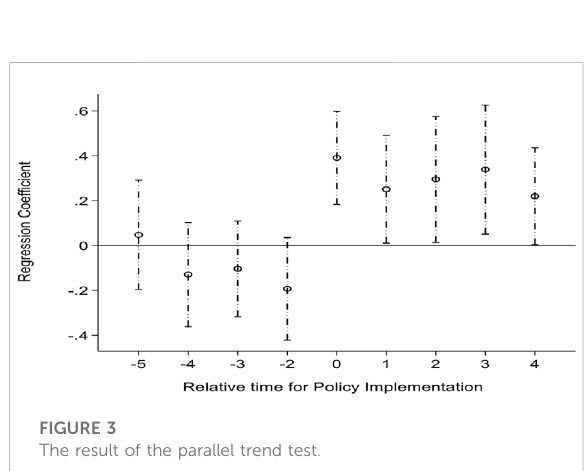
FIGURE 3 The result of the parallel trend